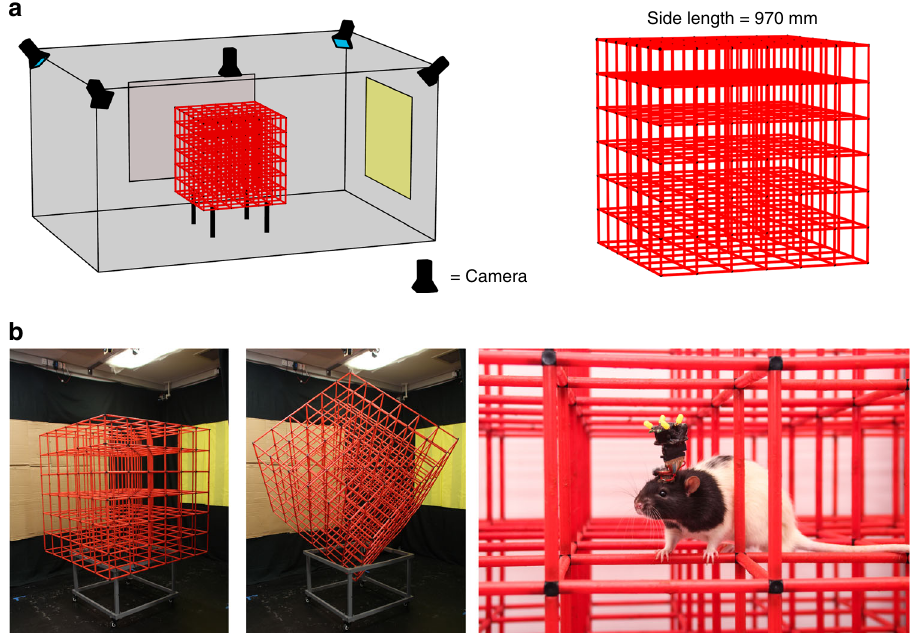
Fig. 1 The recording room and apparatus. a Room and maze schematic, shown in aligned con fi guration. b Photographs showing the aligned lattice maze in position for recording (left) the tilted lattice maze in position for recording (middle) and a rat implanted with an Axona microdrive exploring the aligned lattice whilst connected to the wireless headstage